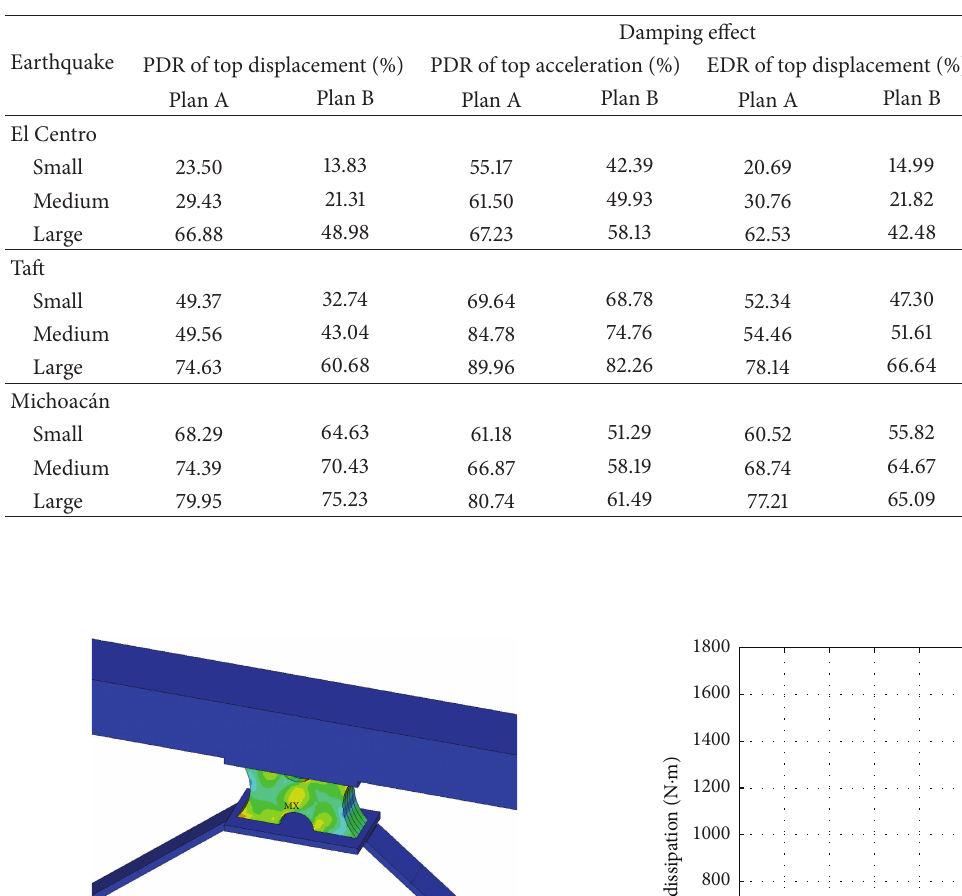
Table 2: Results of damping effect.